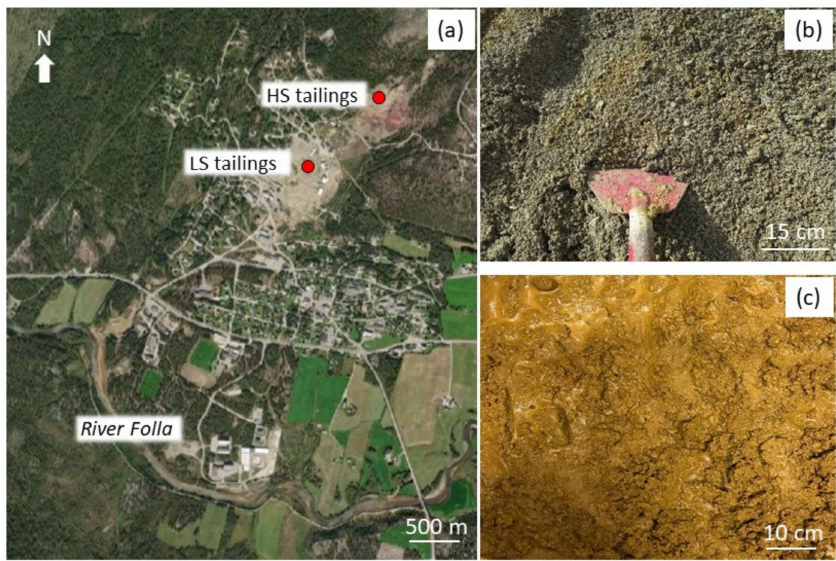
Figure 1. ( a ) aerial view of the Folldal mine with location of the two sites where the HS tailings and the LS tailings were sampled. The location of the River Folla, which is affected by AMD, is also shown. ( b ) HS tailings during homogenisation and ( c ) LS tailings during the column setup. The HS tailings contained significant amounts of Fe and S (14.7 wt% Fe and 5.1 wt%